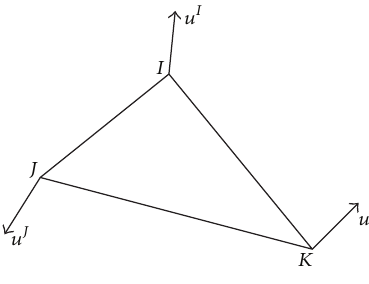
Figure 1: A triangular